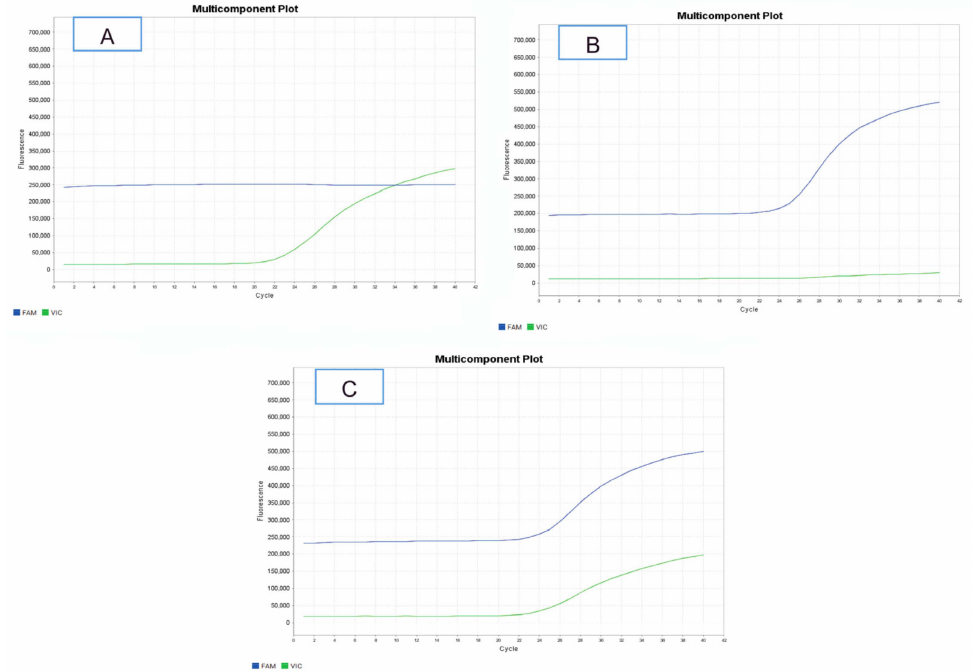
Figure 1. Plots of amplification during genotyping of animals by real-time PCR at position 13,149 of the DIO1 gene. ( A ), CC genotype; ( B ), GG genotype; ( C ), CG